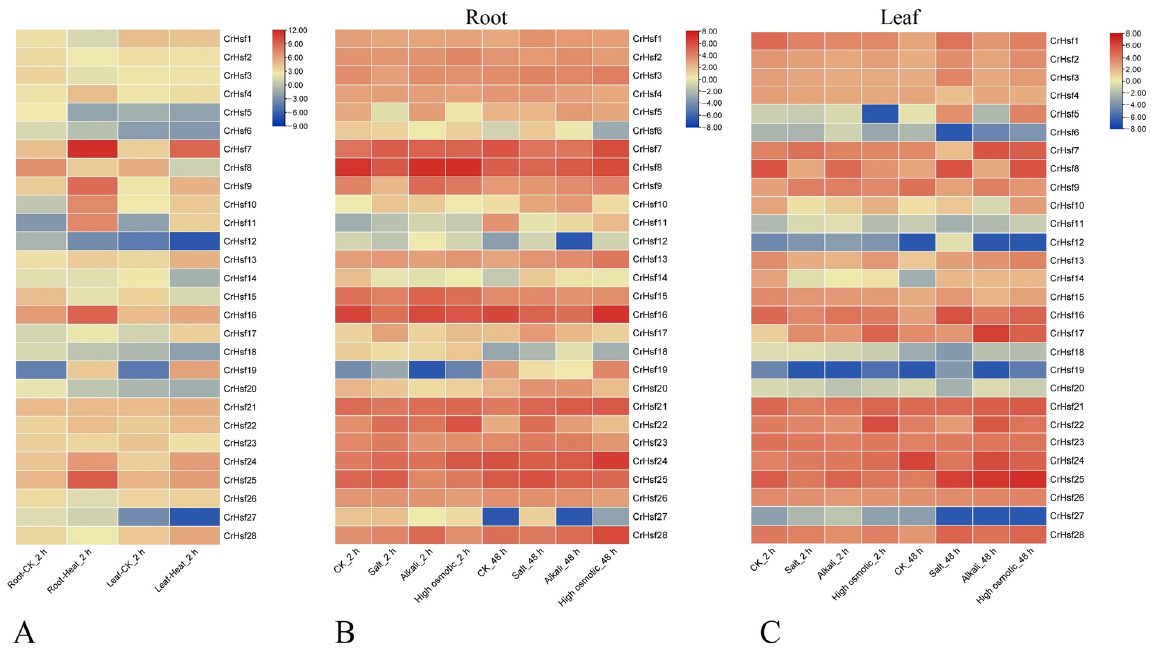
Figure 7. Heatmaps showing: ( A ) The expression levels of the 28 CrHsf genes in roots and leaves of C. rosea seedlings under heat shock stress (45 °C for 2 h); the expression patterns of the 28 CrHsf genes under abiotic stress treatment (600 mM NaCl, 150 mM NaHCO 3 , pH 8.2, 300 mM mannitol, for 2 h and 48 h) in roots ( B ) and leaves ( C ). The expression level of each gene is shown in FPKM values (log2). Orange red denotes high expression levels, and dark blue denotes low expression levels.